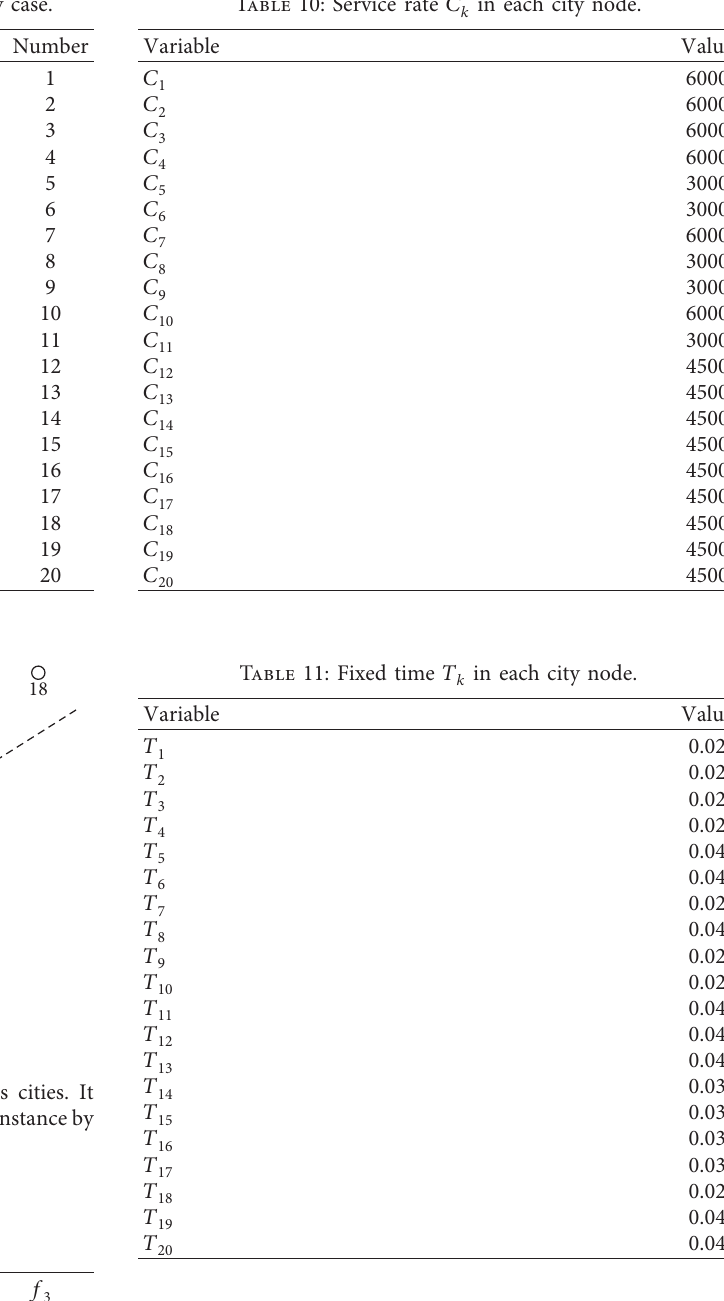
Table 8: CR Express cities mentioned in the study case.